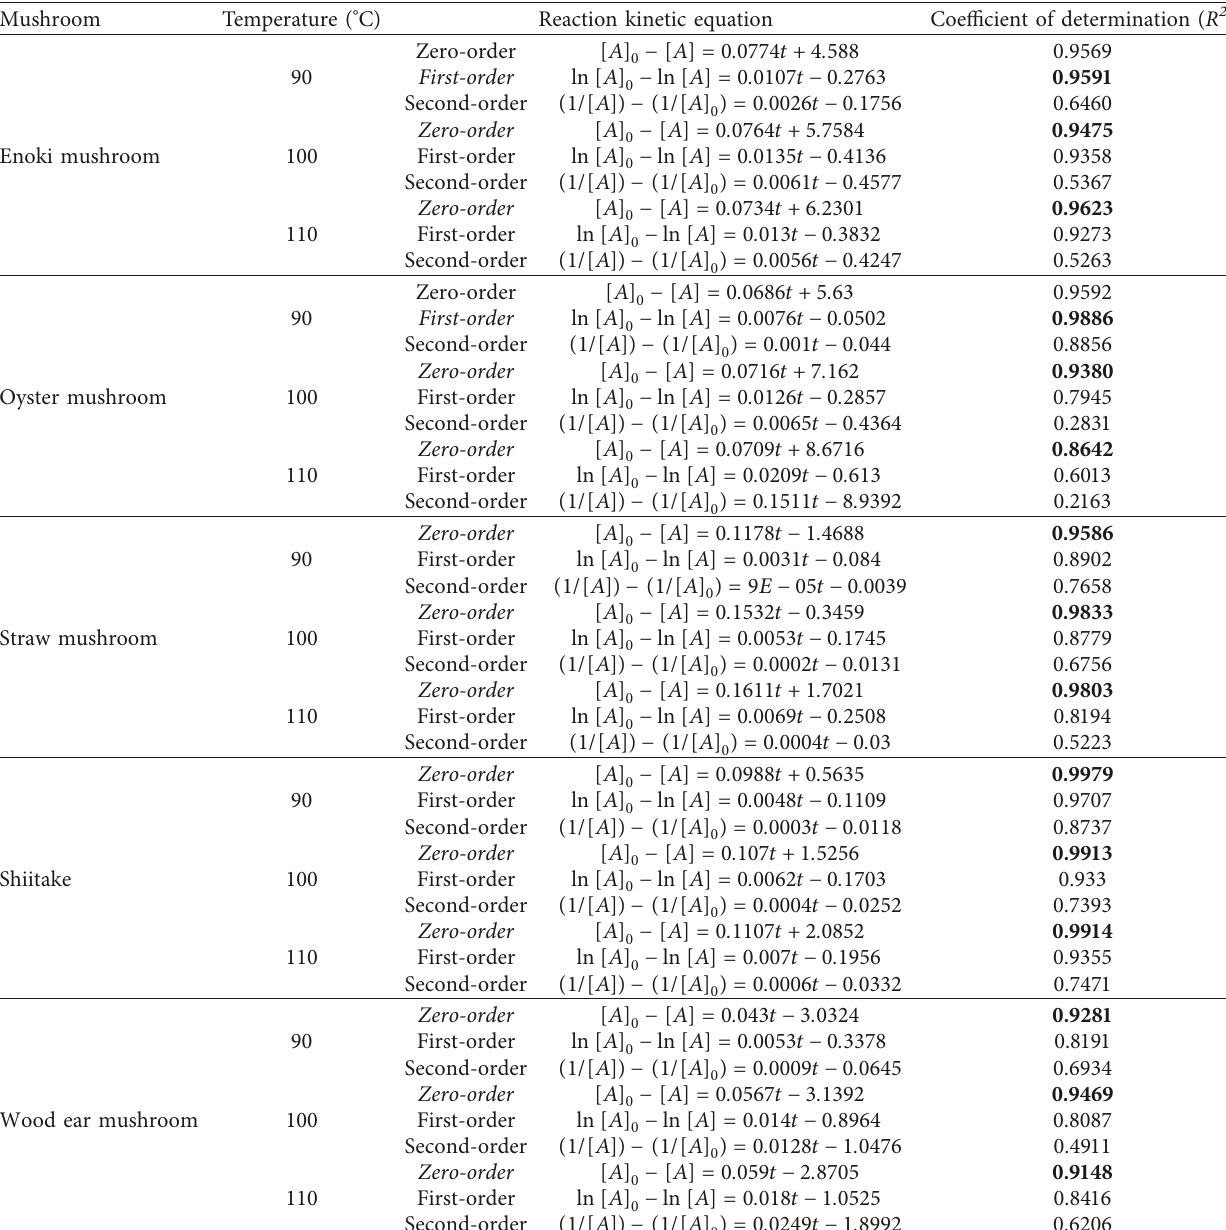
Table 2: Fitting of experimental results to different reaction